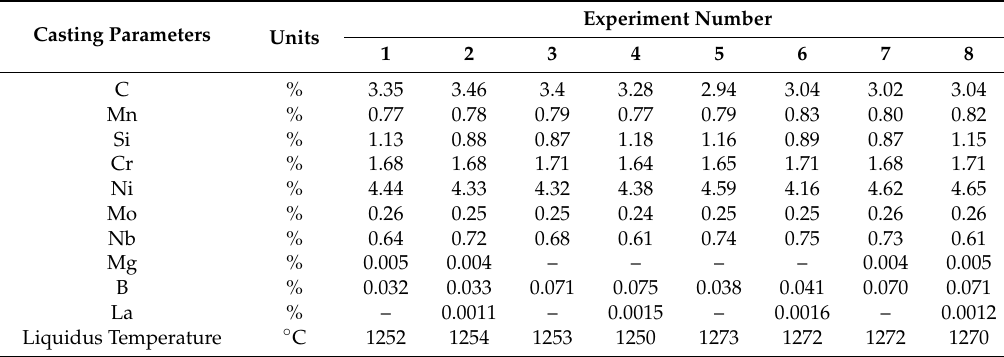
Table 6. Chemical composition of the peripheral working layer in the 8 Experiments.